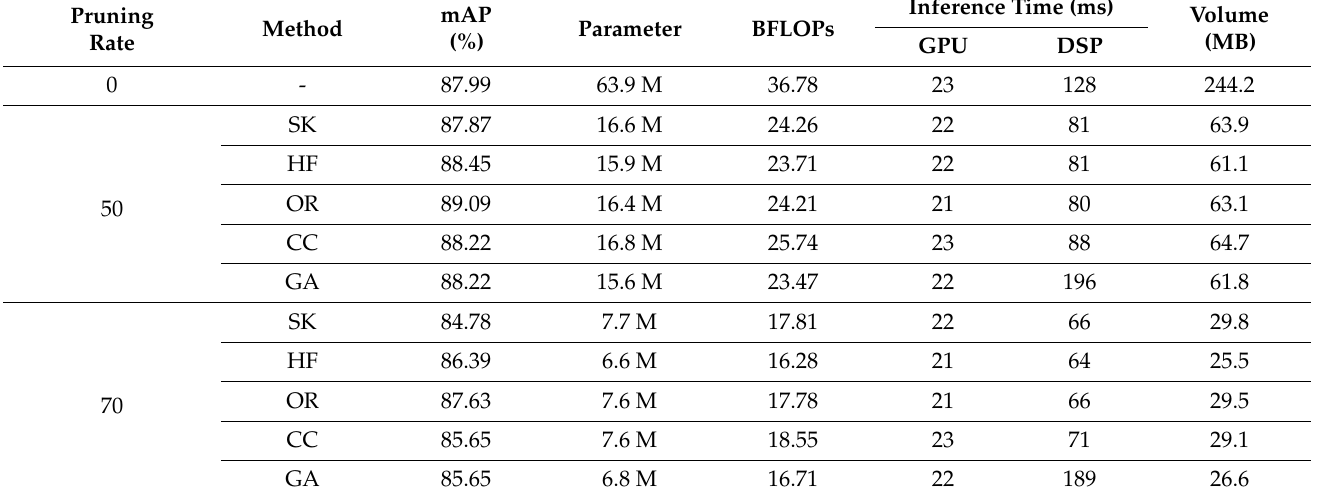
Table 6. Comparison pruning results in SCOD.